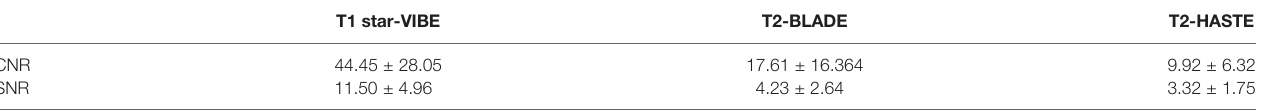
TABLE 6 | Comparison of CNR and SNR in MRI